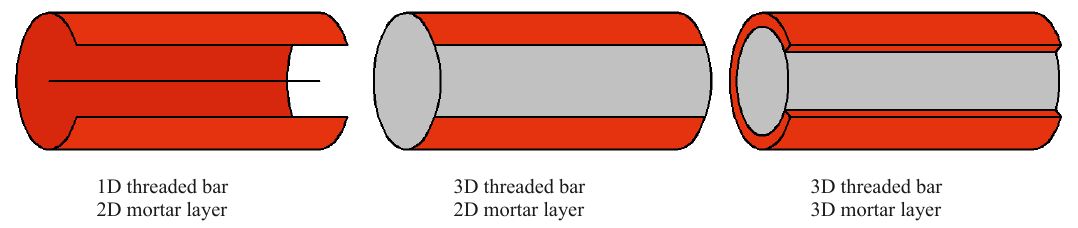
Figure 2. Different scales at which an anchor can be